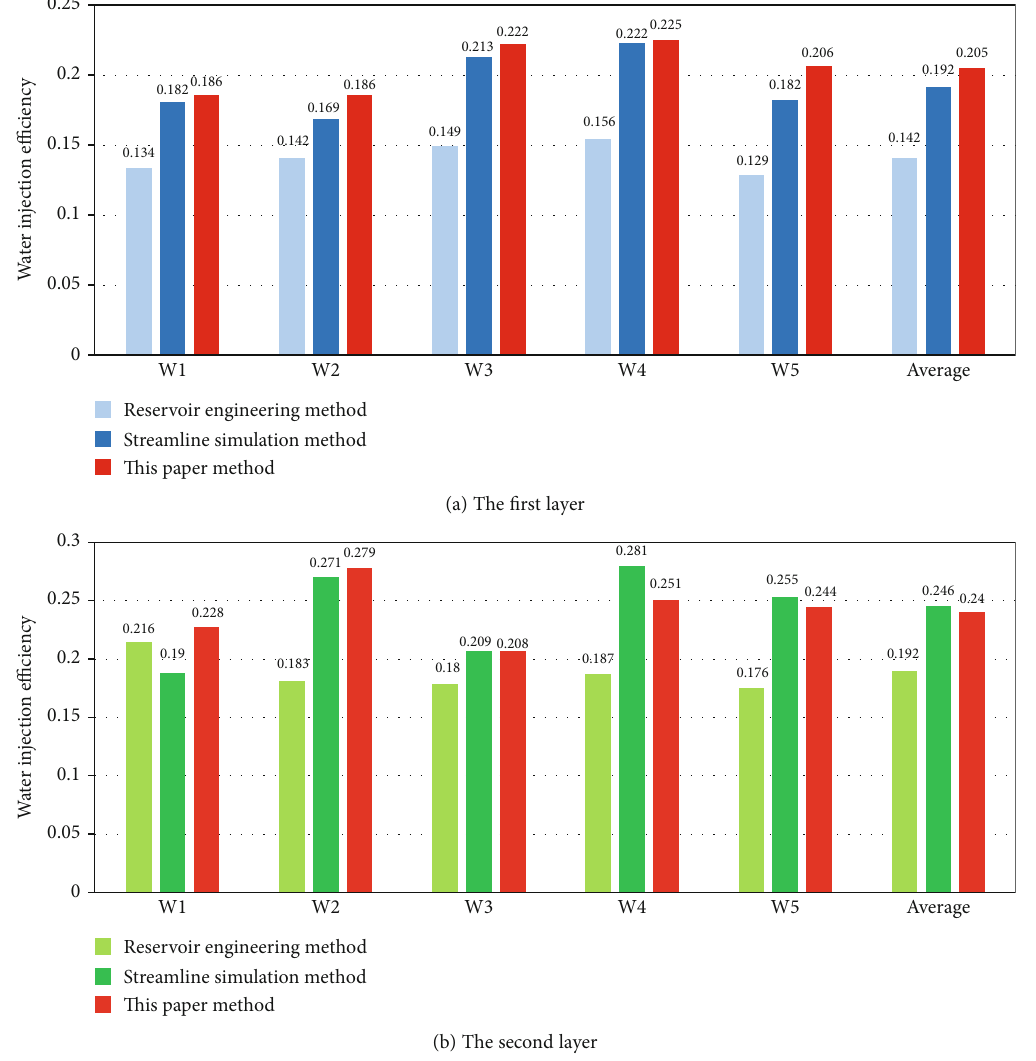
Figure 8: The water injection e ffi ciency of injectors in three di ff erent methods.